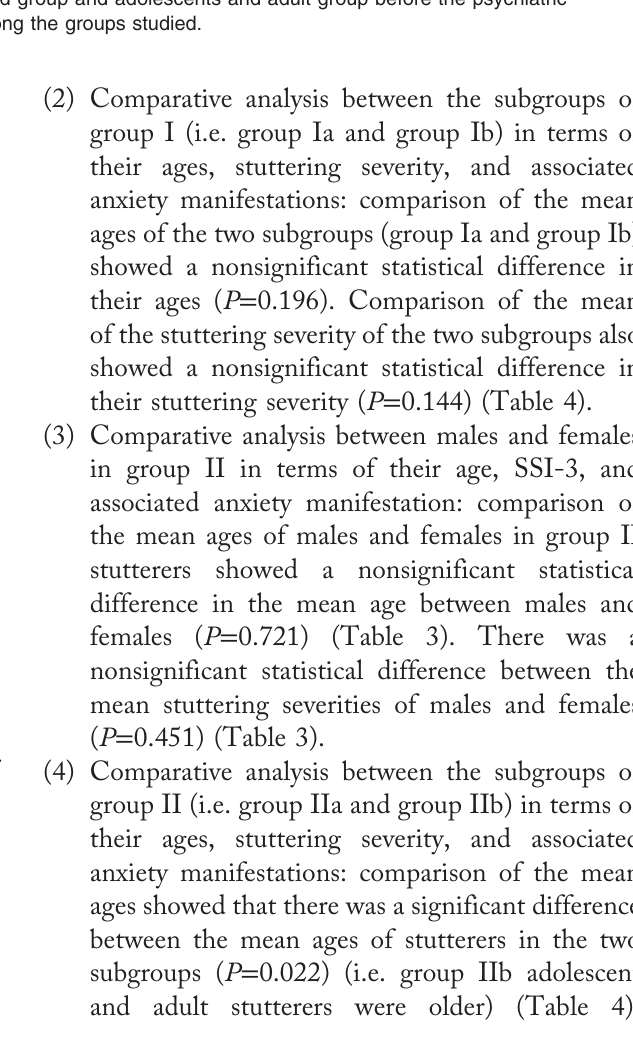
Table 3 Sociodemographic and clinical characteristics of the two main groups (groups I and II) Group of the